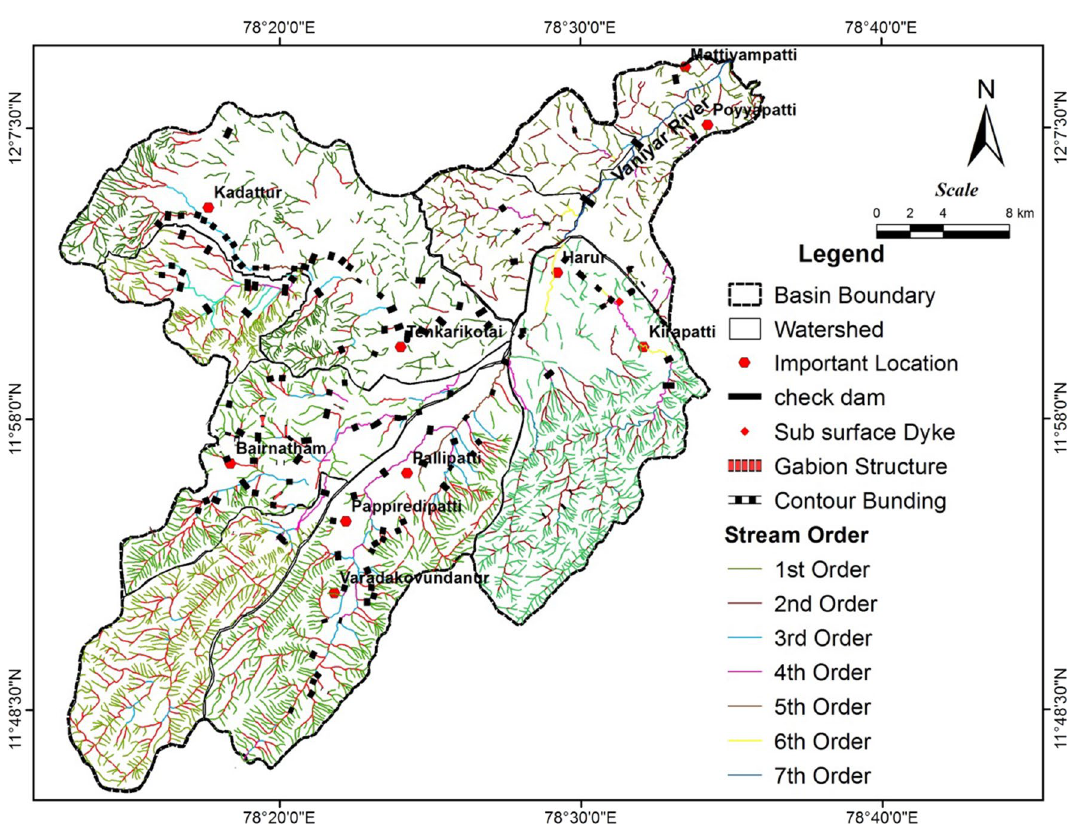
Fig. 2 Stream order with recharge structures in the study area